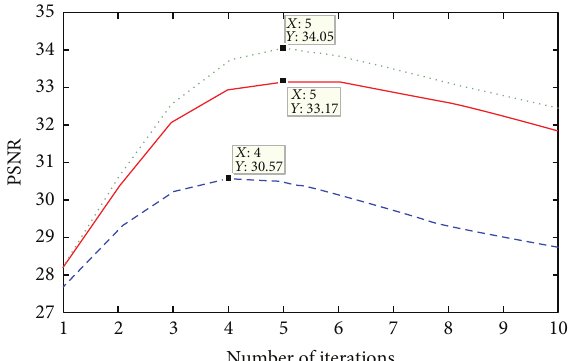
Figure 18: Results showing the variance of PSNR measured against the number of iterations measured for images of various resolutions. It has been found that the number of iterations ranges between 4 and 5 to attain the most denoised output close to the original. The filter settings are as follows: Sigma ( 𝜎 ) for random noise = 12, number of iterations = 4, 𝜆 in (3) = 1/7, and Kappa ( 𝜅 ) in (4) = 15. (⋅⋅⋅) : image resolution 150 × 150, (—): image resolution 256 × 256, and (- - -): image resolution 512 × 512. Various images with the similar resolution have been tested and the averages have been plotted with identical curves with their respective resolutions.